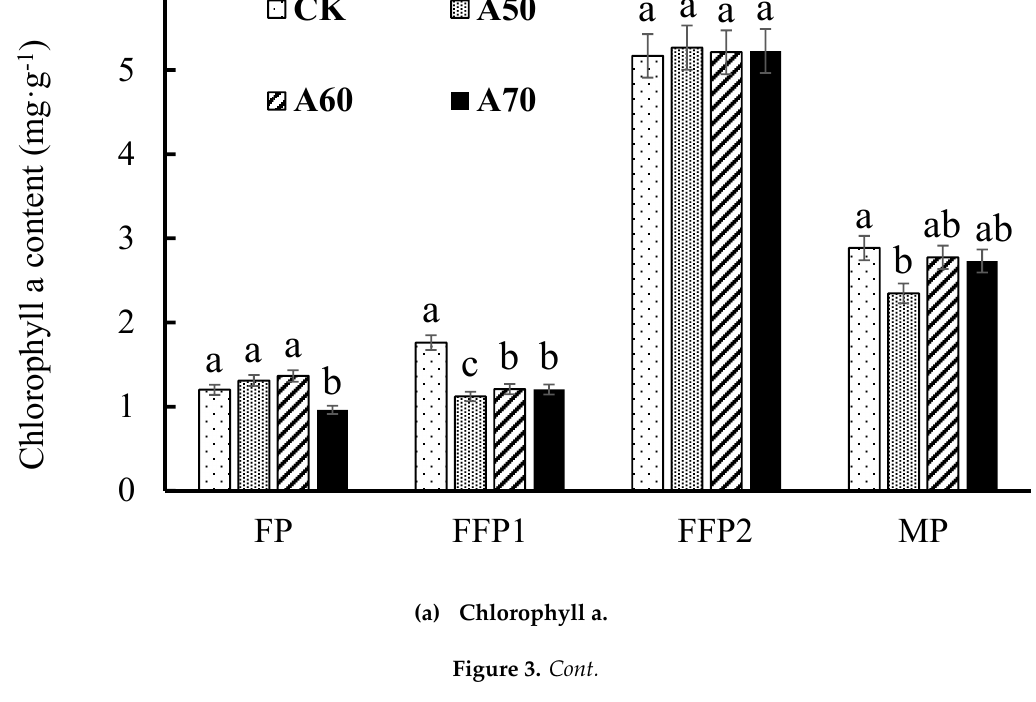
(a) Chlorophyll a. (a) Chlorophyll a. Figure 3.